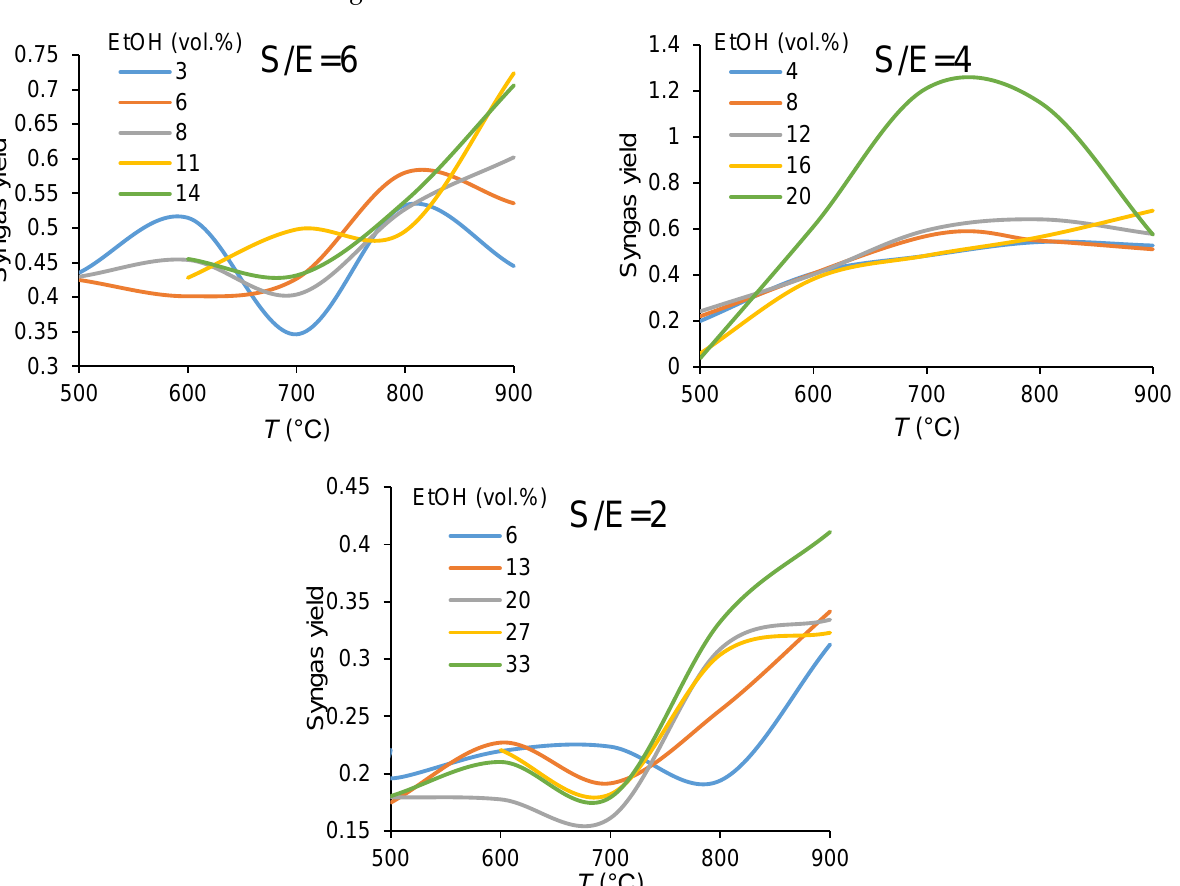
Figure 7. Temperature dependencies of syngas yield in ethanol steam reforming in CMR at different ethanol concentra- tions (in vol. %) and the steam-to-ethanol molar ratios in the feed.